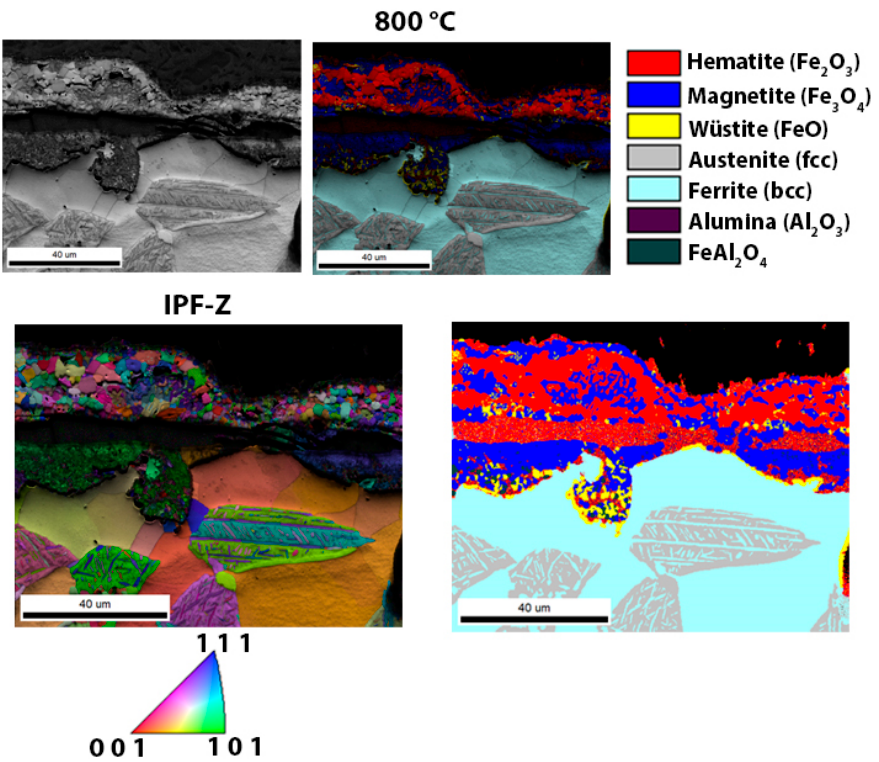
Figure 6. EBSD phase analysis of the oxide layer after high-temperature oxidation at 800 °C, phase analysis and the crystal orientations in the oxide layer formed.